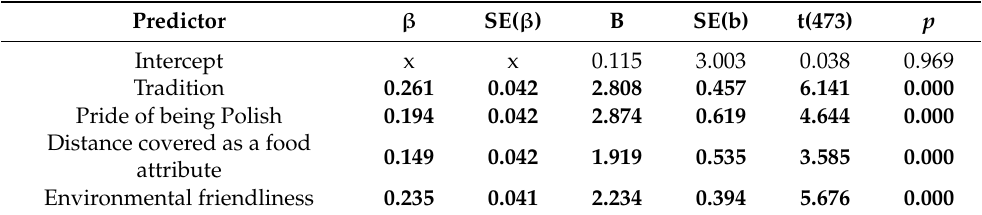
Table 7. Selected predictors of consumer ethnocentrism in the food market among men (a retrograde stepwise regression model).